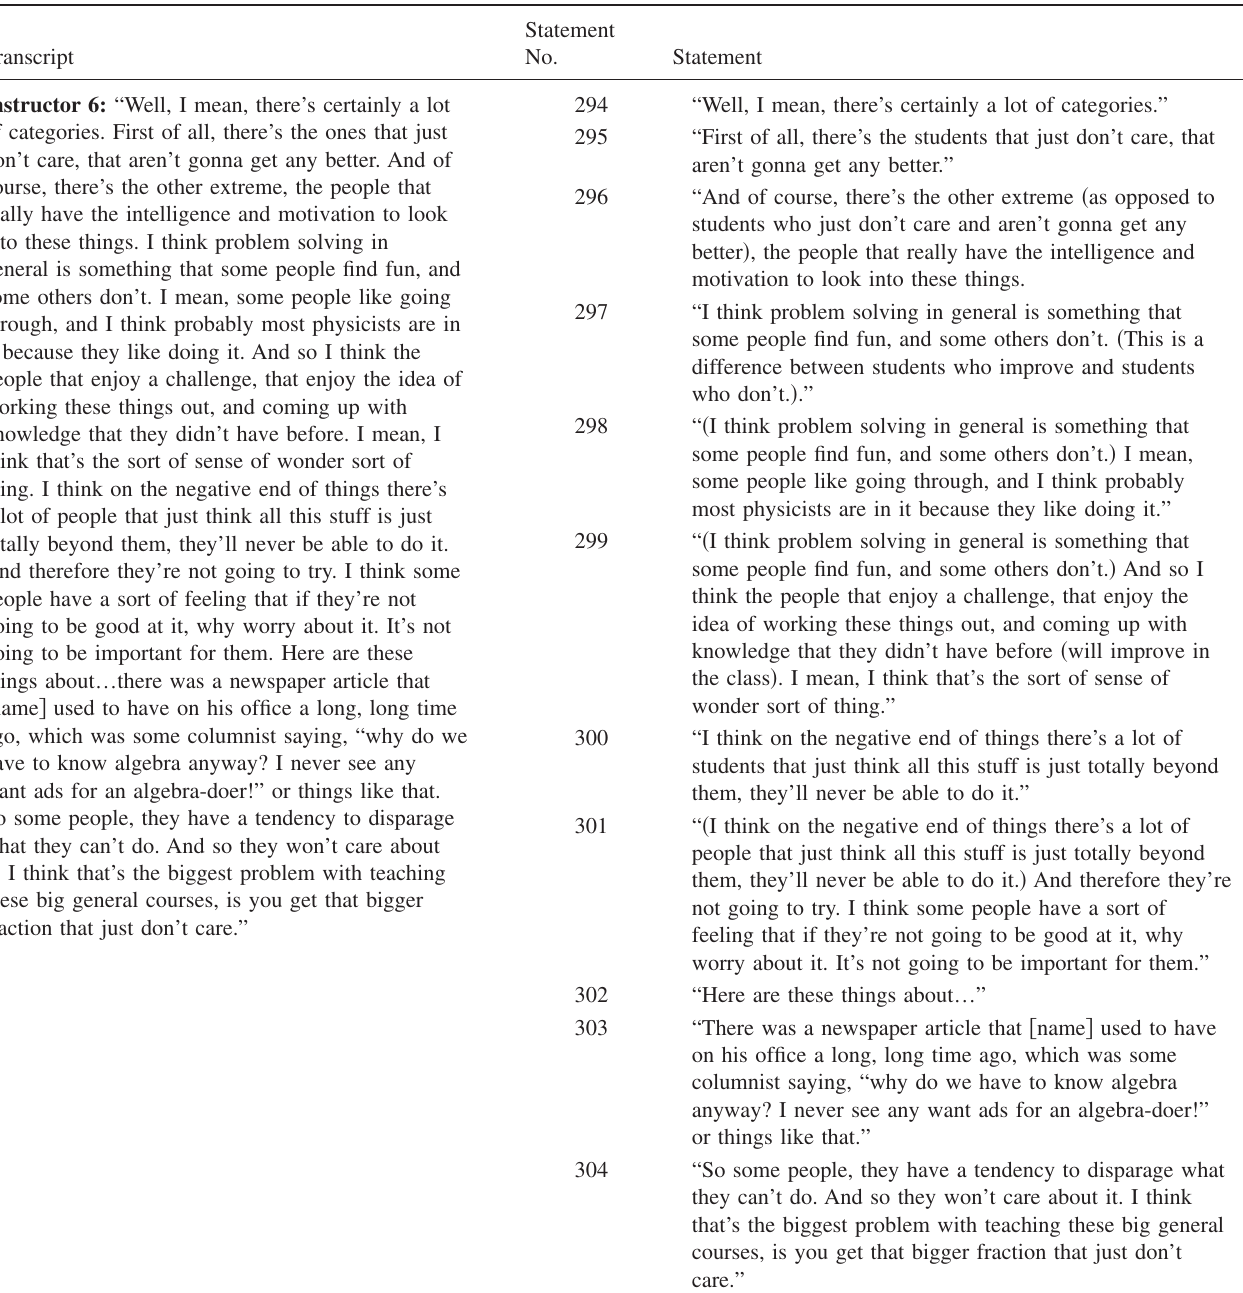
TABLE II. An example of statements made from a portion of the interview transcript. Interviewer: “Ok. I want to talk about two different kinds of students. And looking at your chart (cid:3) created earlier in the interview (cid:4) there’s students that come in knowing stuff, which is great. But there are also a lot of students who don’t come in being able to handle these areas. And of those students that come in without being able to handle them, some of the students get better and some of the students don’t. So I’m wondering what the difference between those two types of students is—the students who improve during the class and the students that